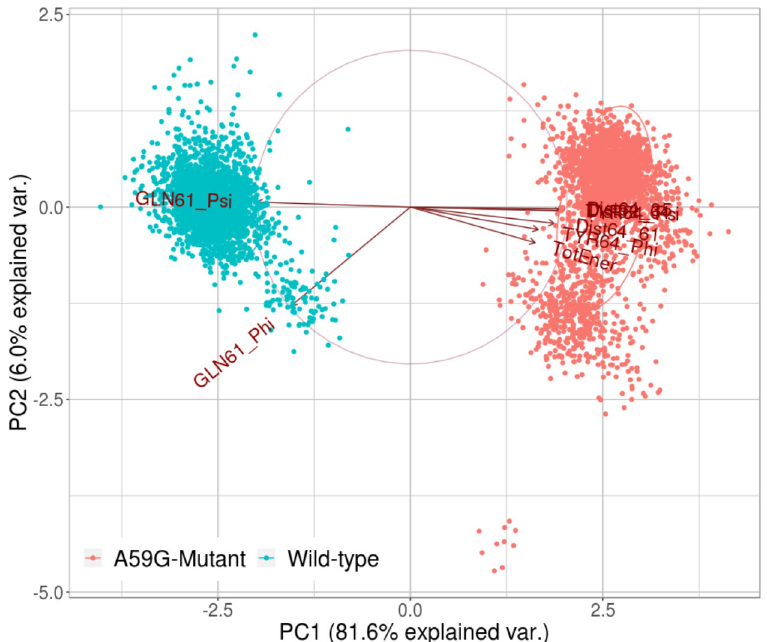
Fig 9. Projections of PC1 on PC2, of the features chosen for multivariate PCA. Cyan and orange color clusters are for wild-type and mutant trajectories, respectively. The individual arrows represent the eight features used for this